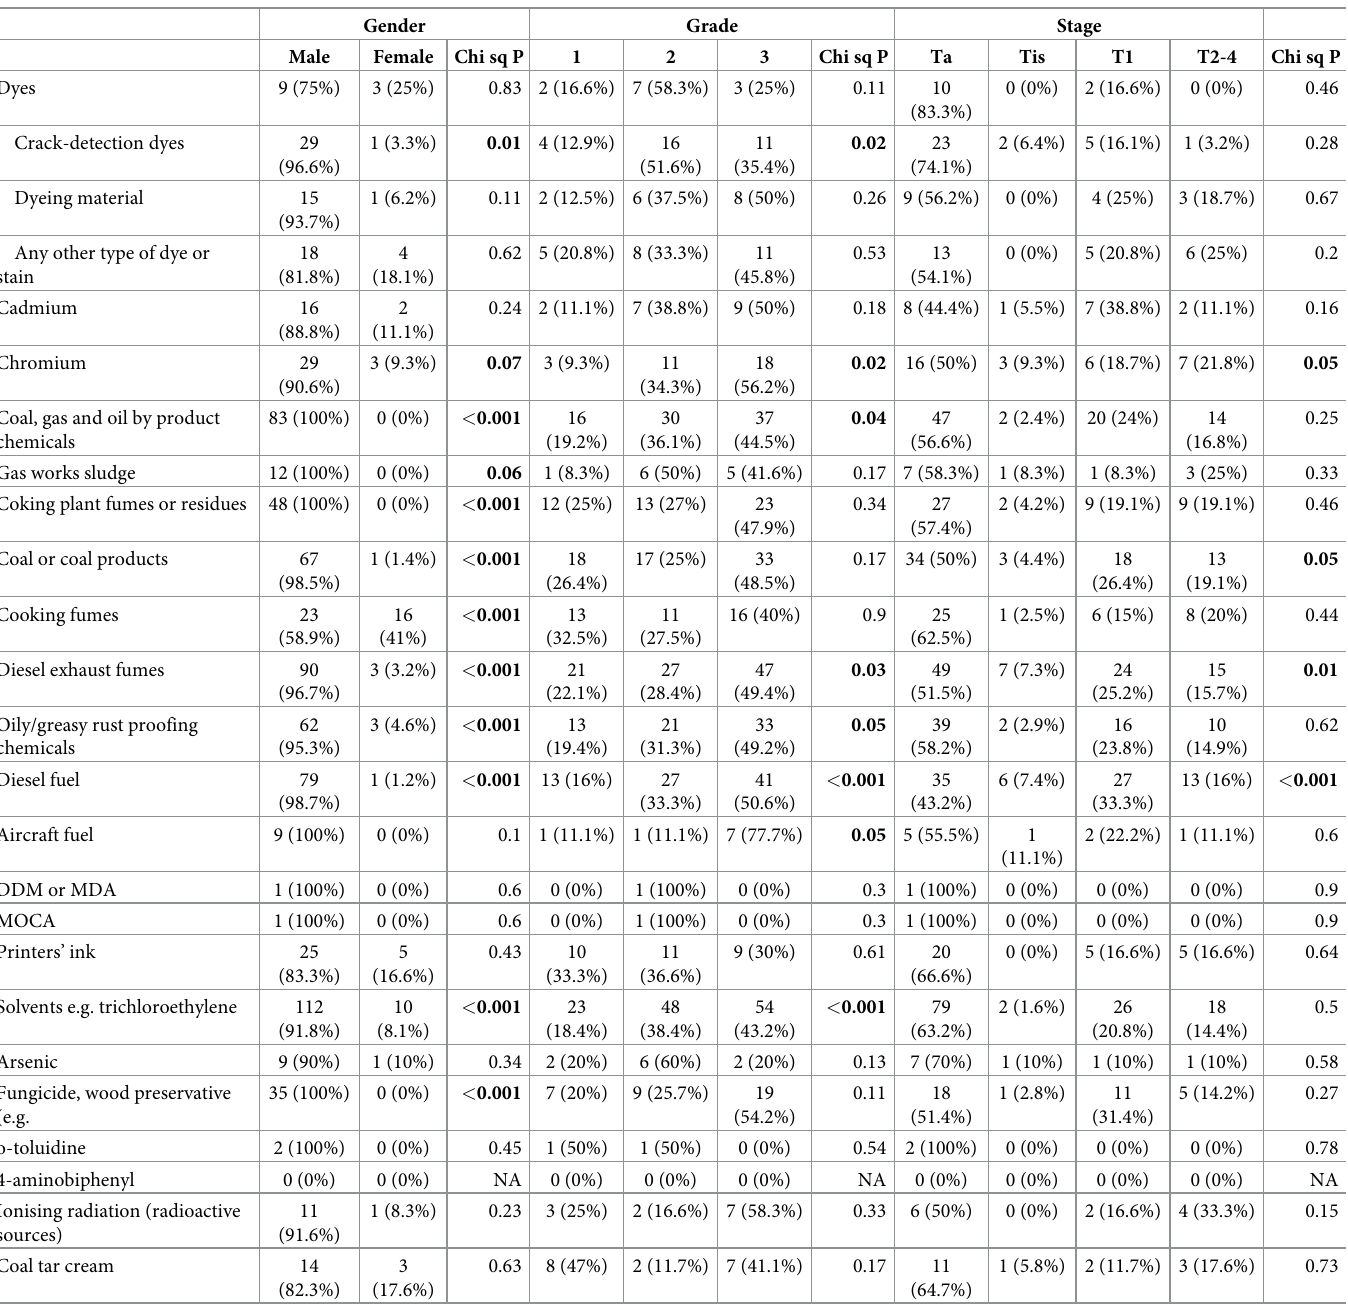
Table 3. Substance exposure compared to patient sex and tumour